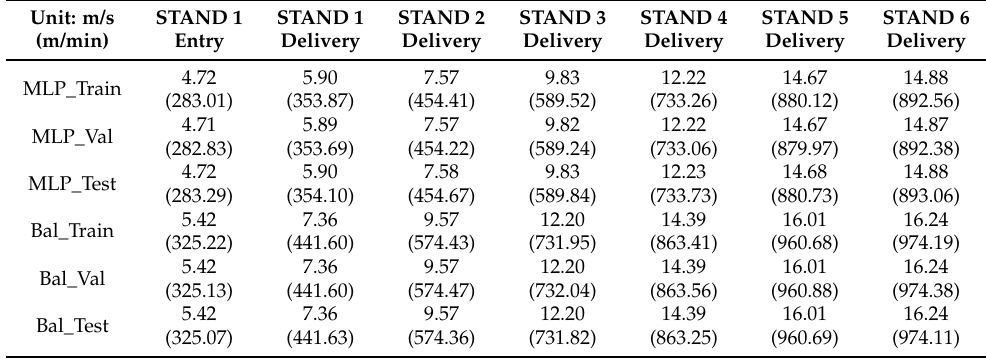
Table 20. The speed comparison results.